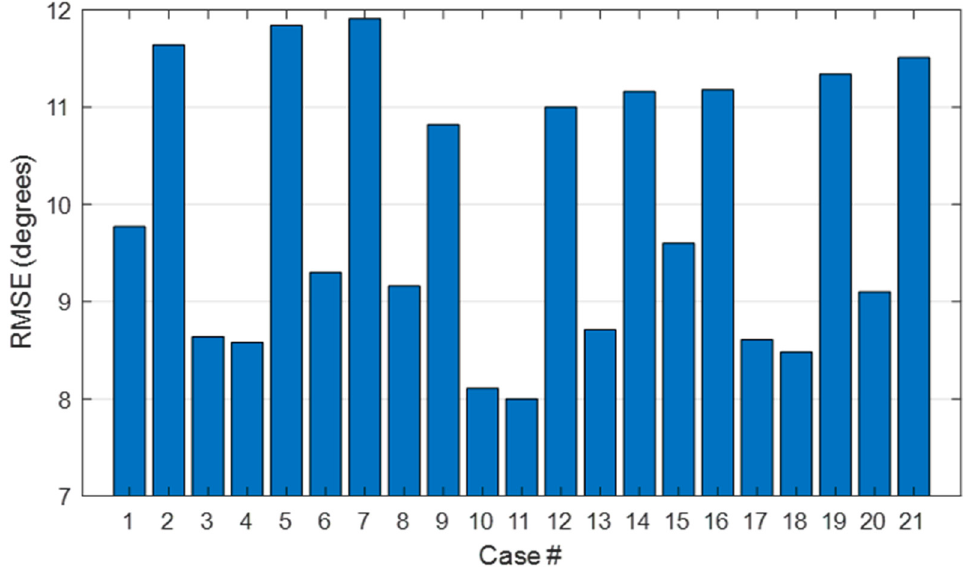
Figure 6. Averaged RMSE across DoF obtained for each case number tested.